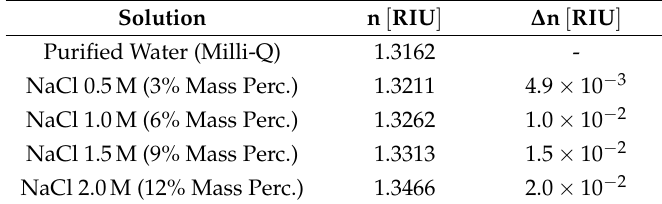
Table 1. Refractive index details of the different injected NaCl solutions at a wavelength of 1.55 µ